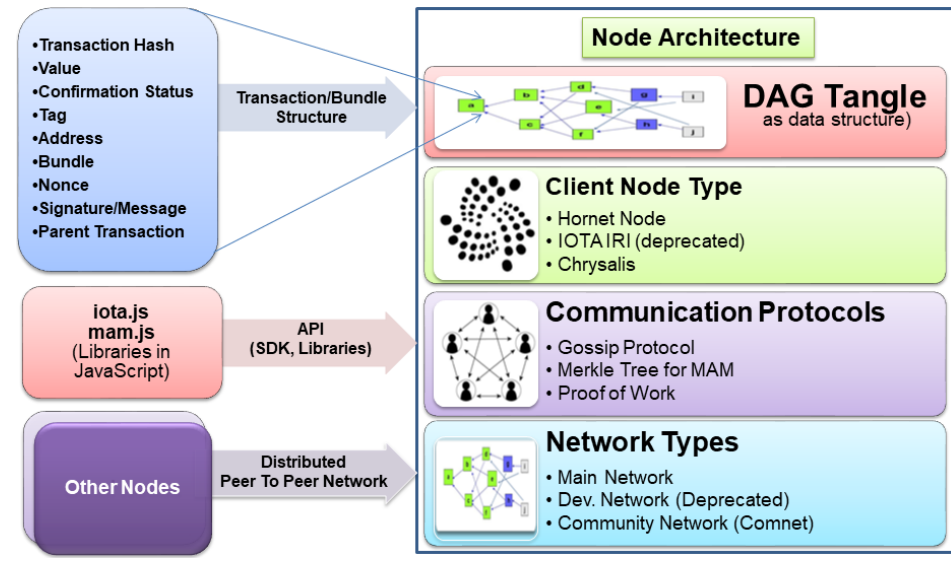
Figure 1. Architecture of the IOTA Platform.